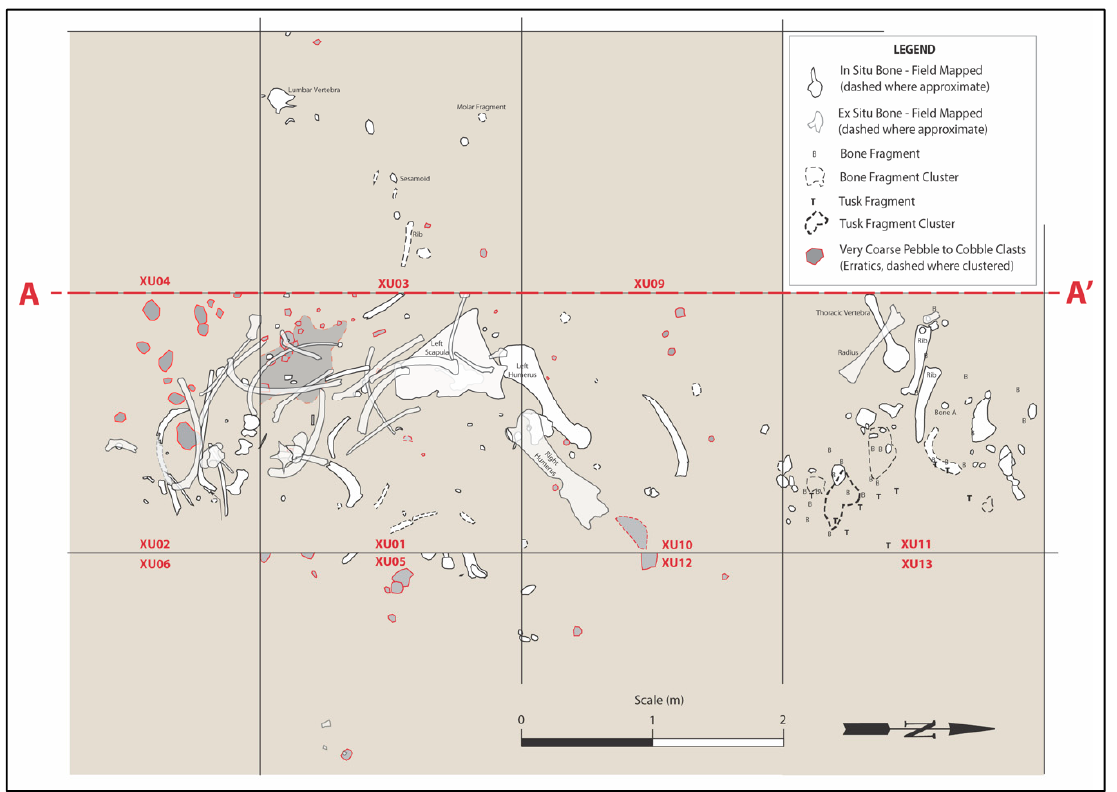
Figure 4. Layout of excavation units: ( a ) Shows the map of the three transects, including A-A’, on to which the stratigraphy in Figure 6 is projected; ( b ) Shows the stair step configuration of the excavation units. Only the darker shaded units in ( a ) are labelled in ( b ).